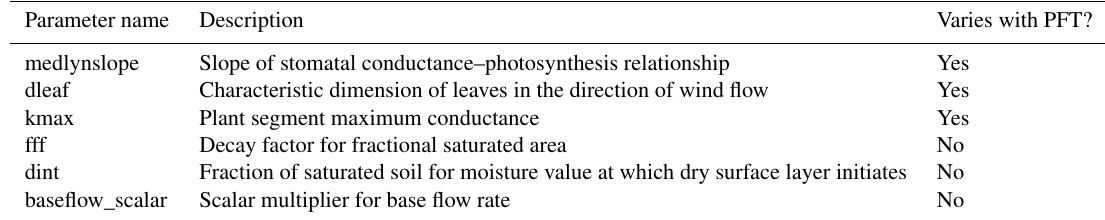
Table 1. CLM5 candidate parameters selected based on sensitivity